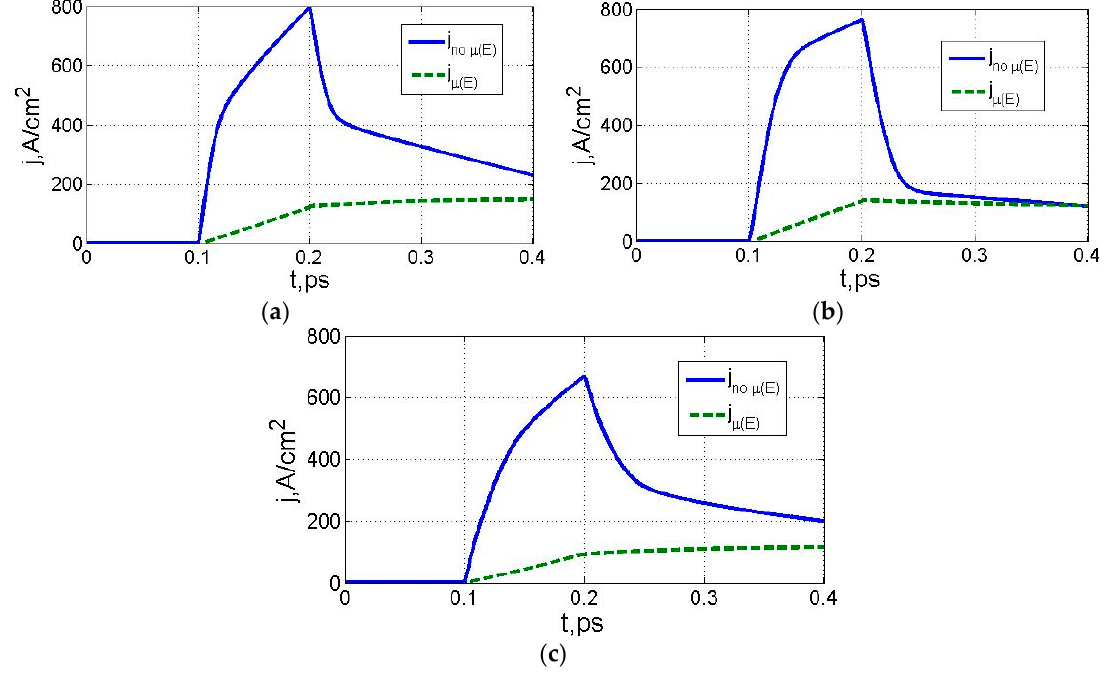
Figure 7. The dependences of photocurrent density modulus on time in GaAs p-i-n ( a ); n-type ( b ) and p-type Schottky-barrier ( c ) photodiodes calculated with the application of different mobility models: